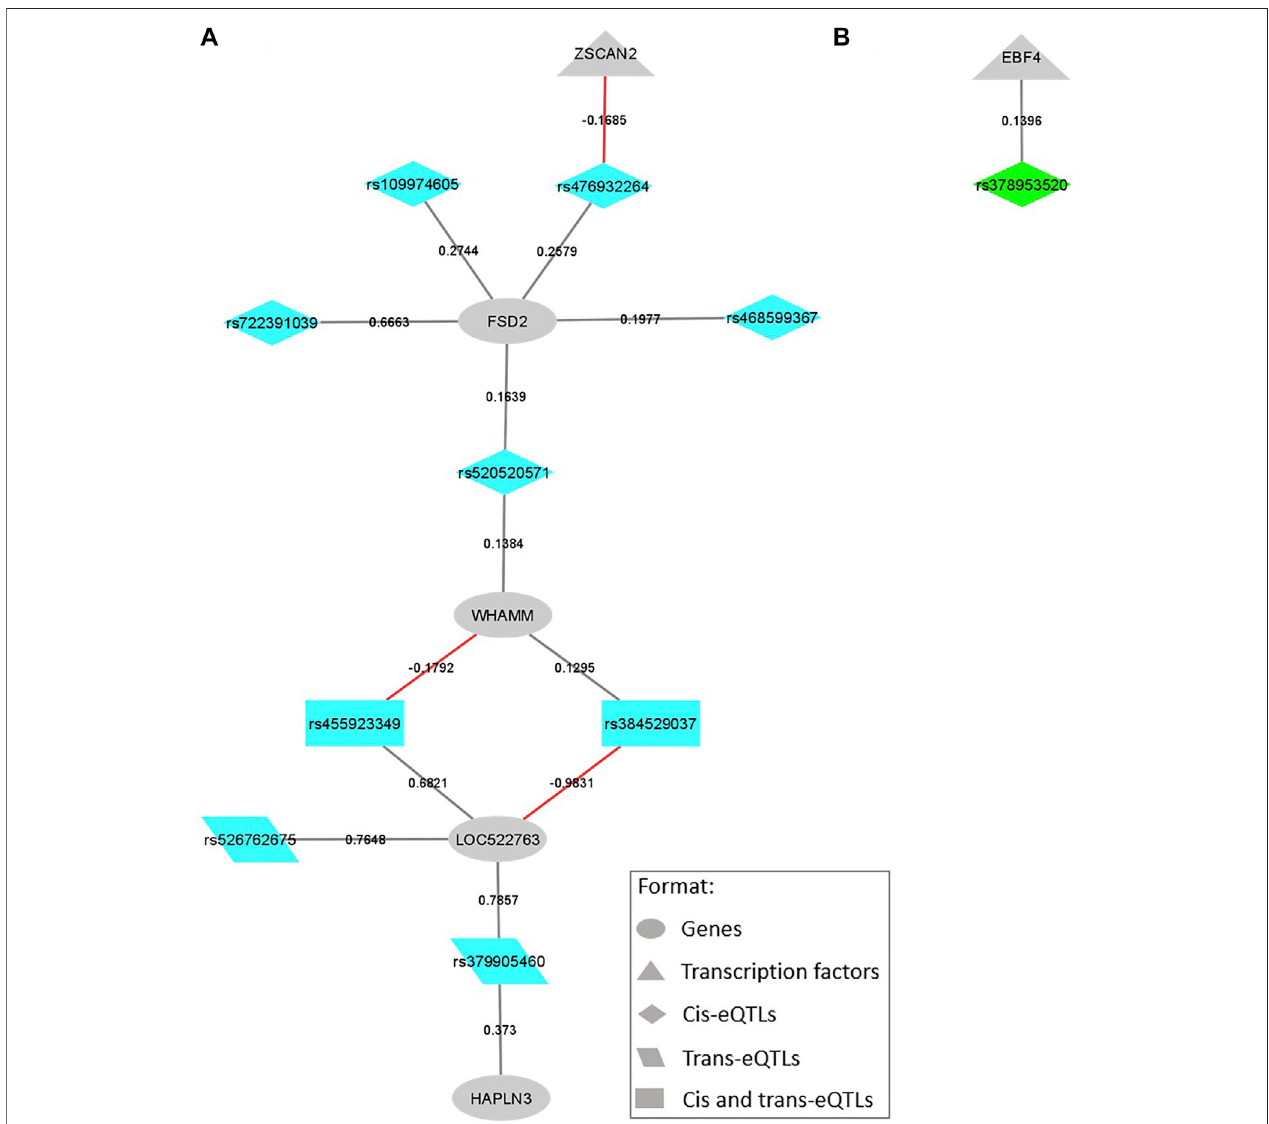
FIGURE 4 | SNP-gene regulation networks representing the eQTL variants located within QTL windows associated with backfat thickness (BFT) and the genes regulated by them, focusing on the variants regulating transcription factors (TFs) and their direct connections. The colors are coded by QTL window: (A) BTA21_23, eQTLrepresentedinblue; (B) BTA13_52,eQTLrepresentedingreen.Alltheformatsaredescribedinthelegend.Graylinesrepresentapositivebeta-valueandredones represent a negative beta-value.